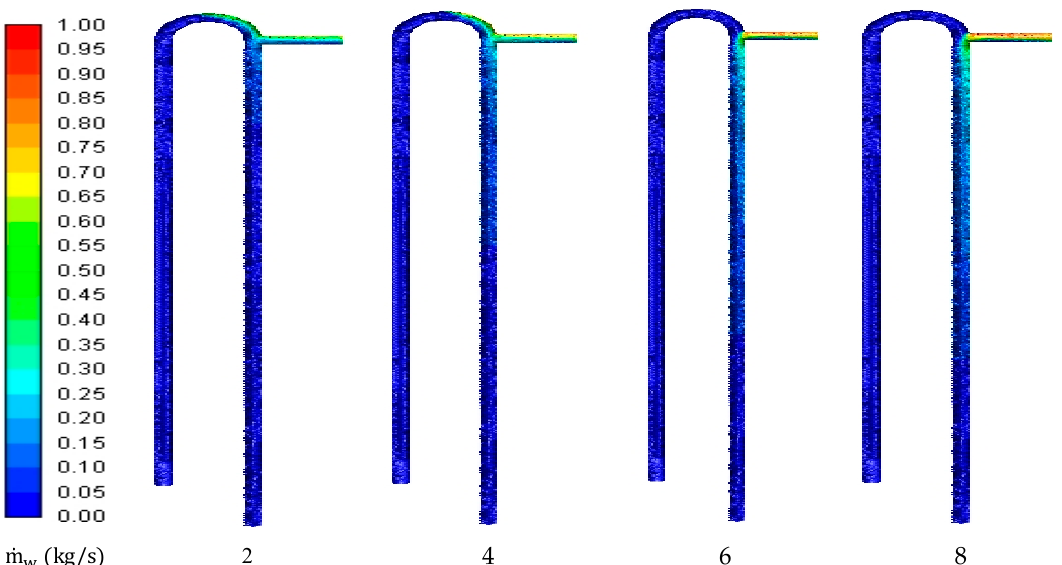
Figure 15. Air volume fraction contours at different flow ratios and X (cid:2933) = 4306.59, α (cid:2923) = 0.2 , X (cid:2932) = 0.1 .